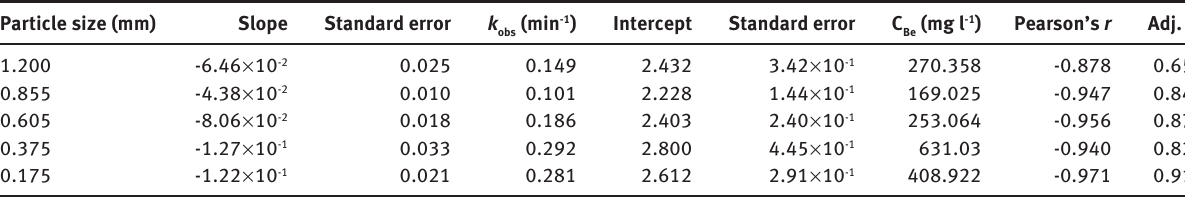
Table 2: First-order kinetics model for the isothermal green solid-liquid extraction of andrographolide at 80 ° C from Andrographis panicu- lata (AP) for different particle sizes and a solid-liquid ratio of 1:10 (g ml -1 ).